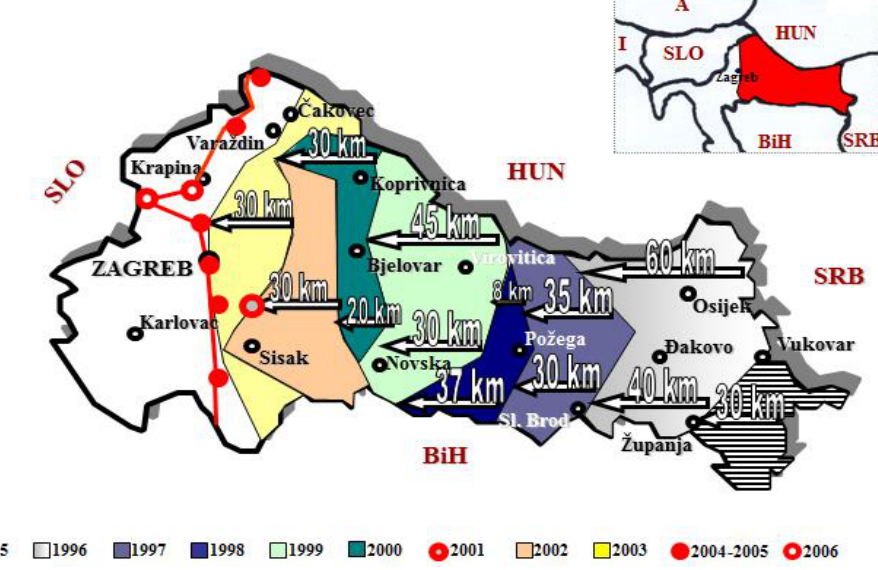
Figure 1. Distribution of western corn rootworm (WCR) in Croatia, established using spatial and density monitoring techniques.